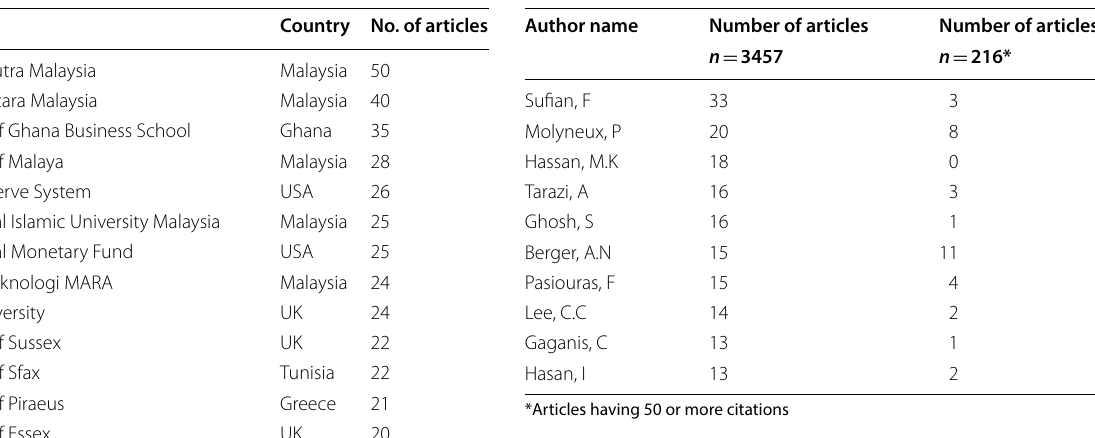
Table 2 Top contributing organizations with location